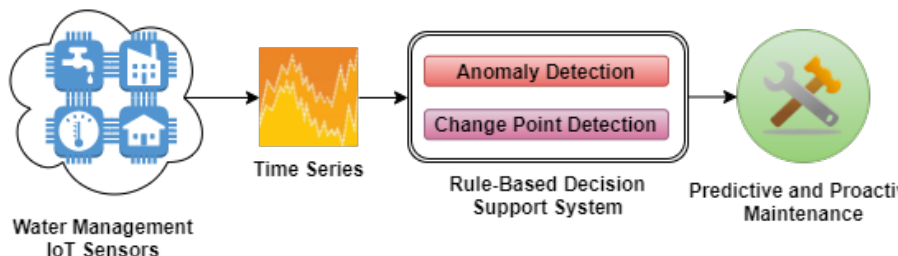
Figure 4. Workflow for predictive and proactive